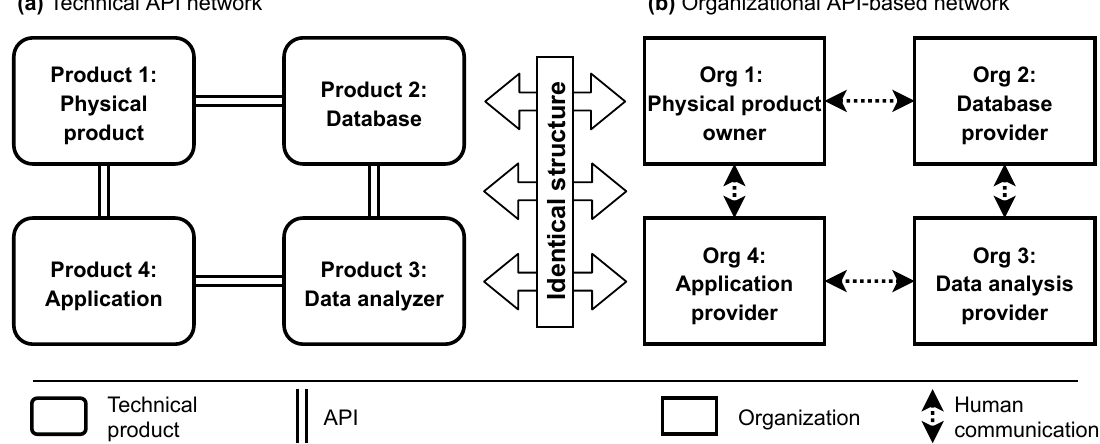
Figure 12. Example illustration of API-based business network framework. The data from Product 1 owned by Organiza- tion 1 go through a loop via digital products before providing an application for the physical product. The structure can be of any form and does not need to be a